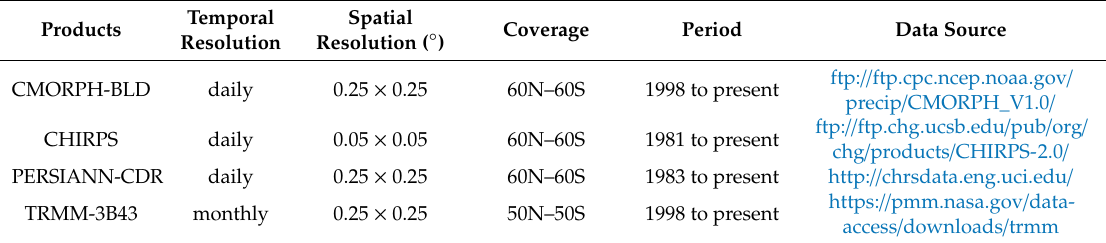
Table 1. Detailed description of four satellite-based precipitation